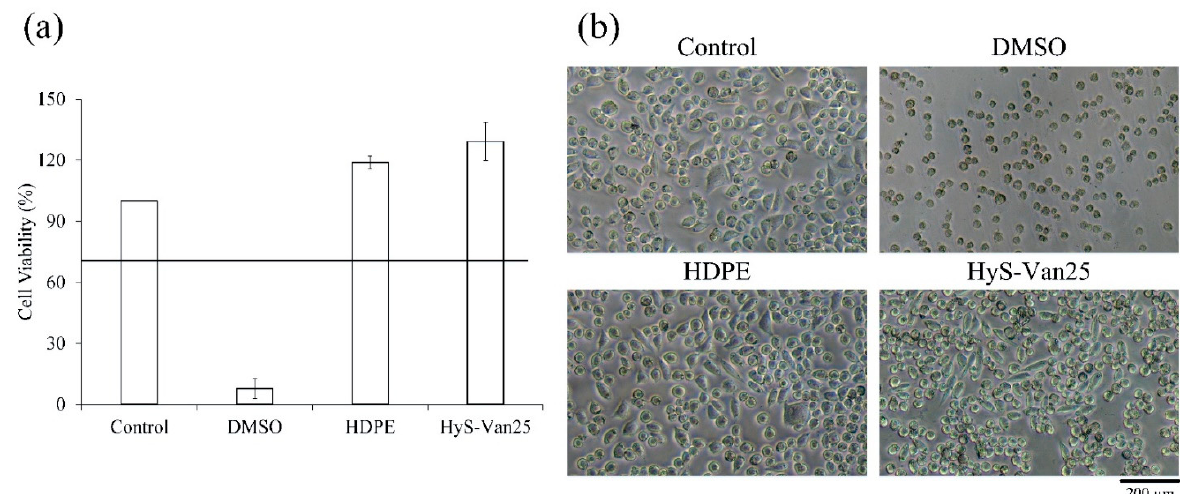
Figure 8. ( a ) Quantitative cell viability ( n = 6) and ( b ) qualitative cell morphologies of L929 cells cultured for 24 h in a solution of hydrogel macrospheres impregnated with vancomycin after sterilization (HyS-Van25).